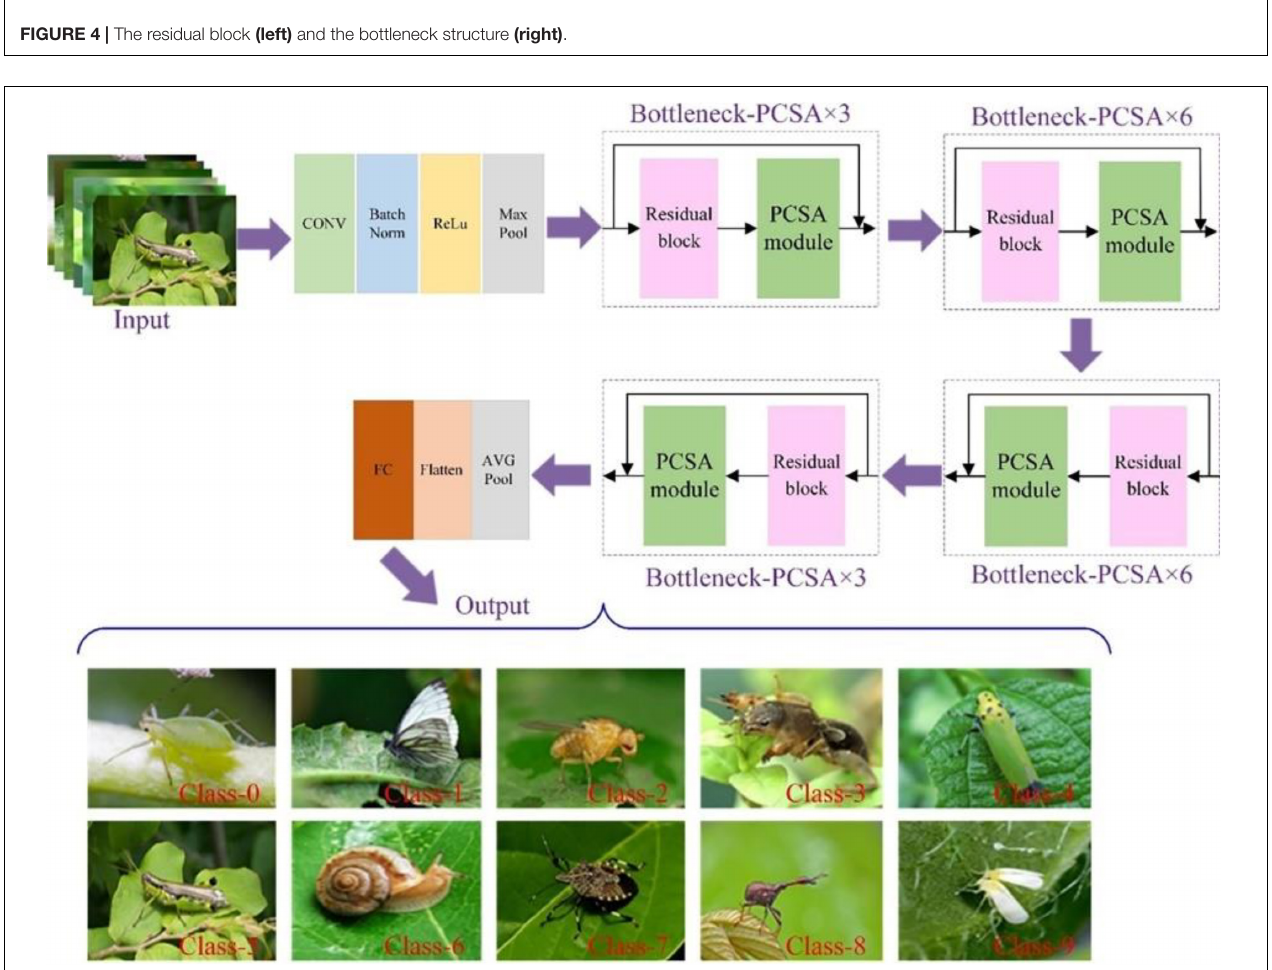
FIGURE 5 | The structure of the crop pest recognition